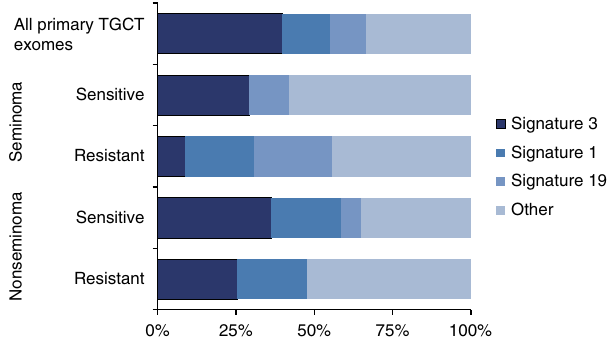
Fig. 6 COSMIC mutational signatures. COSMIC SNV mutation signatures identi fi ed in TGCT, organized by histology and platinum response. Analyses were performed on 247 primary tumours with exome sequencing data (ICR1, ICR2, DFCI and TCGA series) after excluding nine primary tumours with missing histology. Signatures were derived from somatic SNVs from primary tumours pooled together within each group as indicated. COSMIC signatures 1, 3 and 19 are displayed separately, whilst other represents the contribution from the remaining signatures